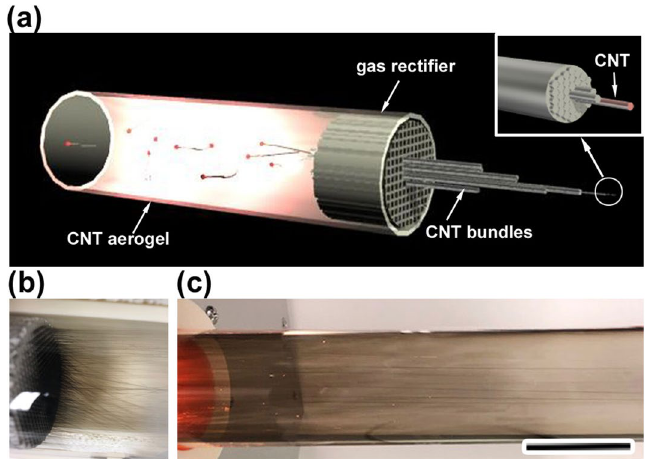
Figure 1. ( a ) Schematic of the fabrication process of aligned CNT bundles, demonstrating that floating CNTs flow into the straight channels of a gas rectifier, macroscopic CNT bundles then protrude from the outlet of the gas rectifier. ( b ) A photograph of the gas rectifier taken after the fabrication of CNT bundles. ( c ) CNT bundles growing in the direction of gas flow (from left to right in the photograph). Scale bar: 5